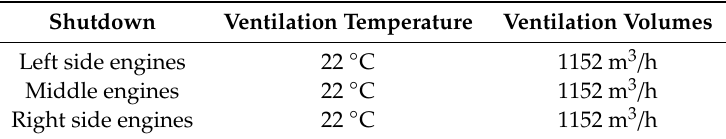
Table 7. Engine shutdown test results.